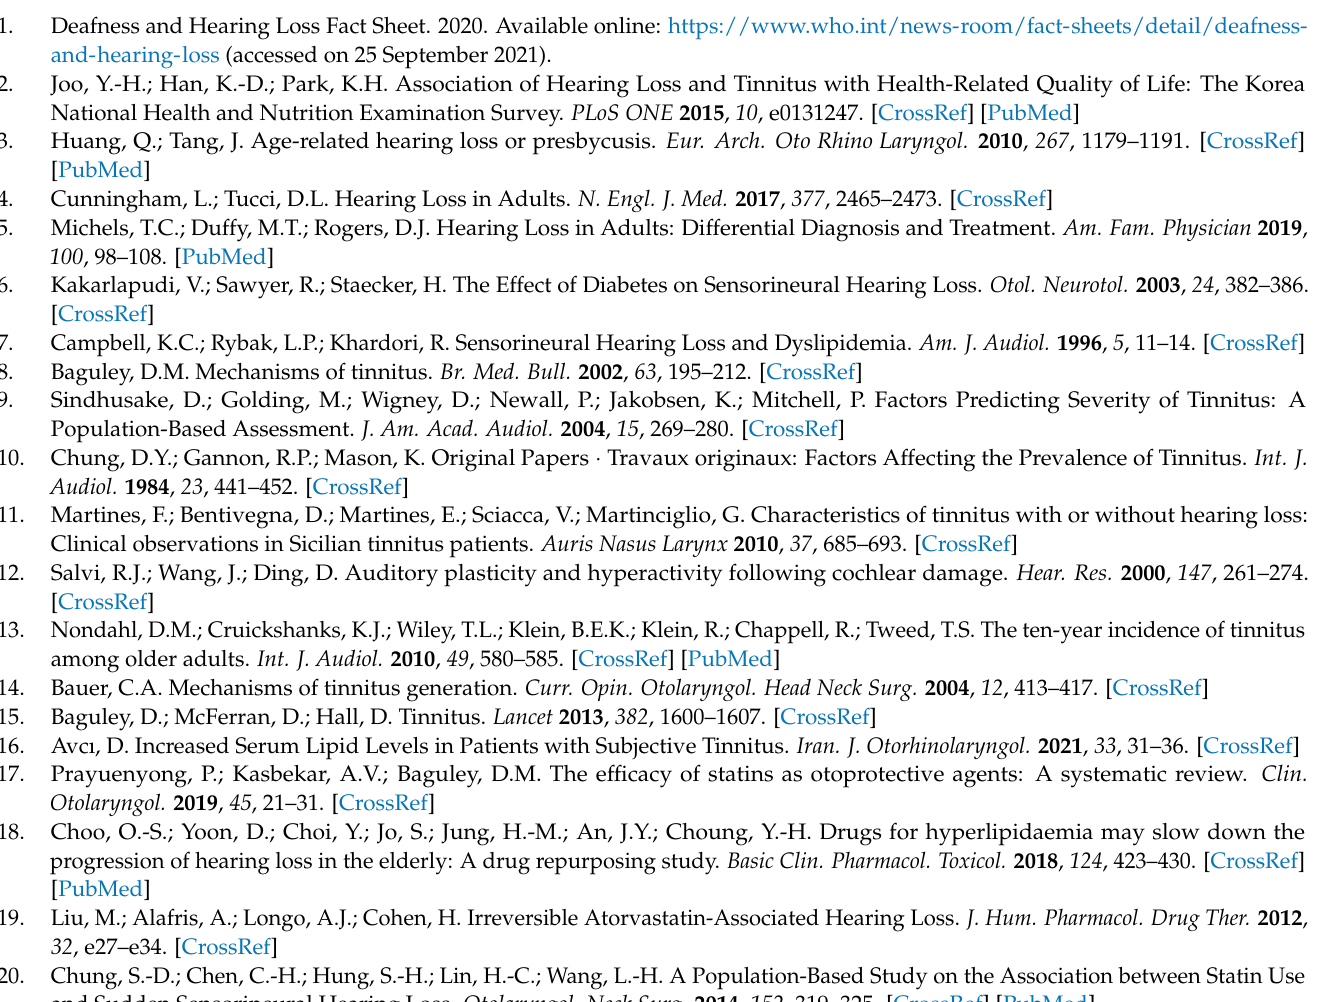
Table S3: Univariate and multivariable logistic regression analyses for sensorineural hearing